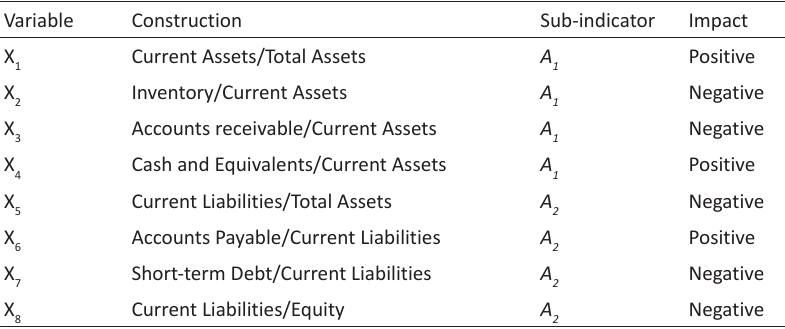
Table 1. Indicators of working capital management strategy of a business